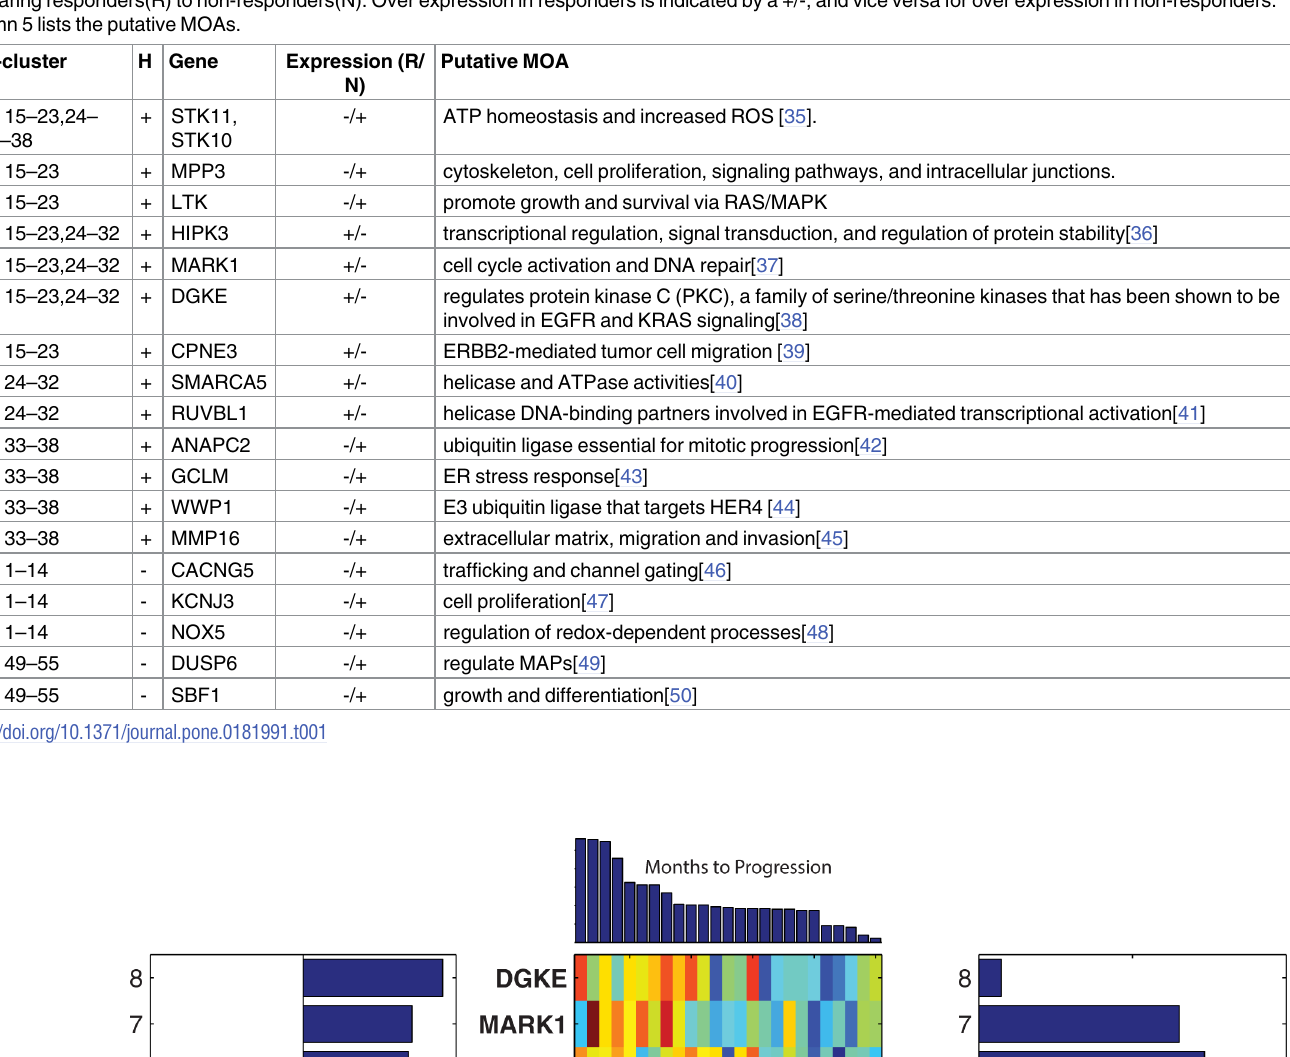
PLOS ONE | https://doi.org/10.1371/journal.pone.0181991 August 8,